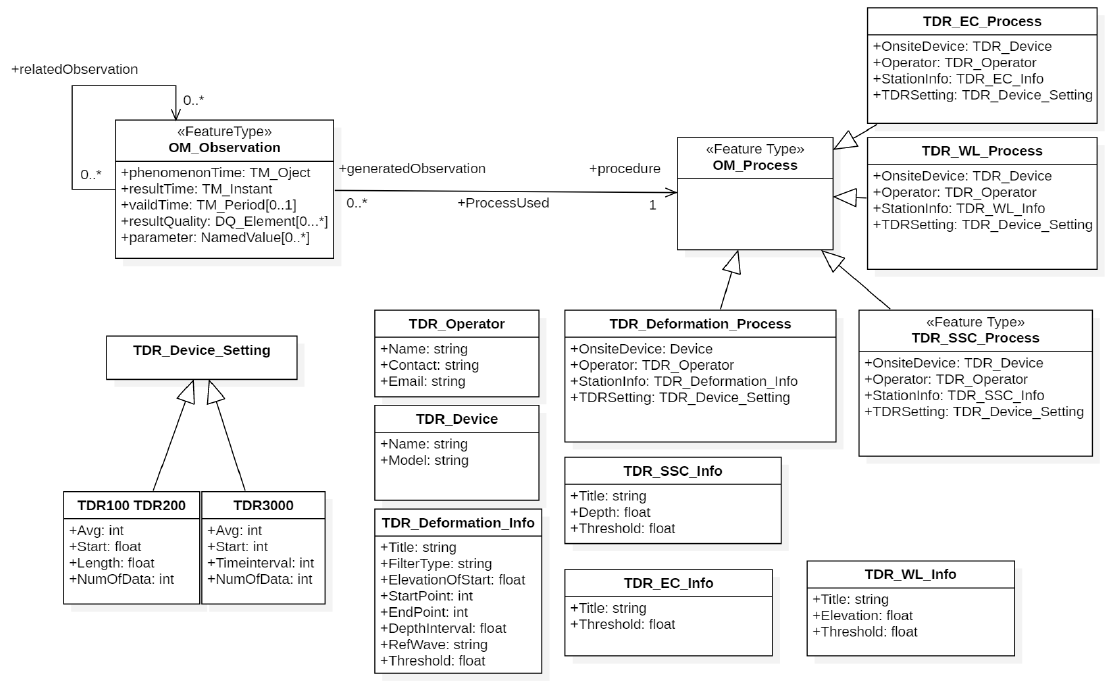
Figure 6. Class diagram of TDR OM_Process conceptual model.